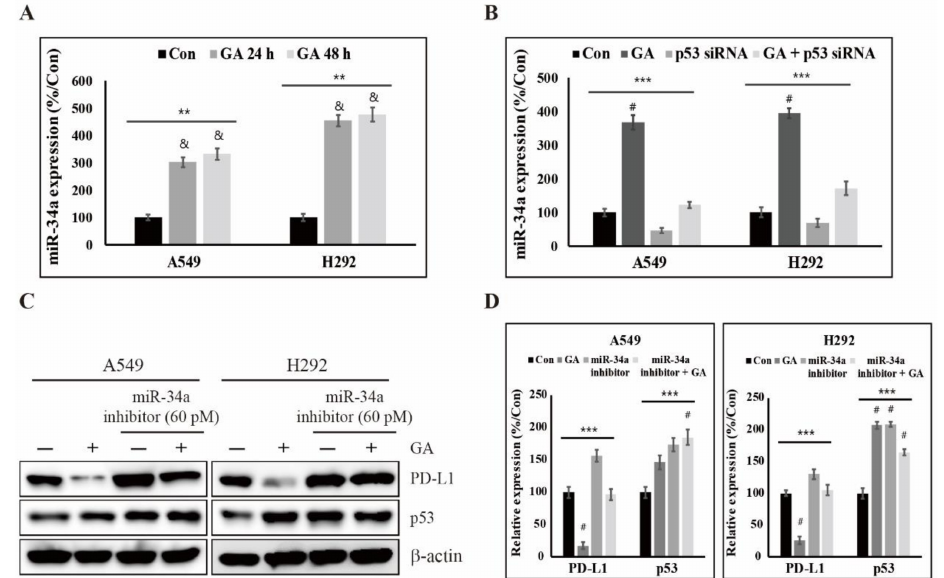
Figure 5. GA upregulates the PD-L1 expression by p53 via miR-34a. ( A ) Relative expression levels of miR34a after treatment of GA (A549: 400 µ M; H292: 100 µ M) for 24 and 48 hours. Data are representative of three independent experiments. ** p < 0.01 (ANOVA); & p < 0.01 vs. control. ( B ) The expression levels of miR-34a in A549 and H292 cells, treated with GA (A549: 400 µ M; H292: 100 µ M), p53 siRNA (60 pM) or GA plus p53 siRNA were detected by RT-PCR at 48 hours. The relative expression levels of miR-34a were determined using densitometry and normalized to U6. Data are representative of three independent experiments. *** p < 0.001 (ANOVA); # p < 0.001 vs. control. ( C ) The expression levels of p53 and PD-L1 protein in A549 and H292 cells, treated with GA (A549: 400 µ M; H292: 100 µ M) or 30 pM miR-34a inhibitor, were detected by western blotting at 48 hours. ( D ) The relative expression levels of p53 and PD-L1 protein were determined by densitometry and normalized to β -actin. Data are representative of three independent experiments. *** p < 0.001 (ANOVA); # p < 0.001 vs. control. 2.6. The Downregulation of PD-L1 Expression by GA Induces the Combination E ff ect with PD-1